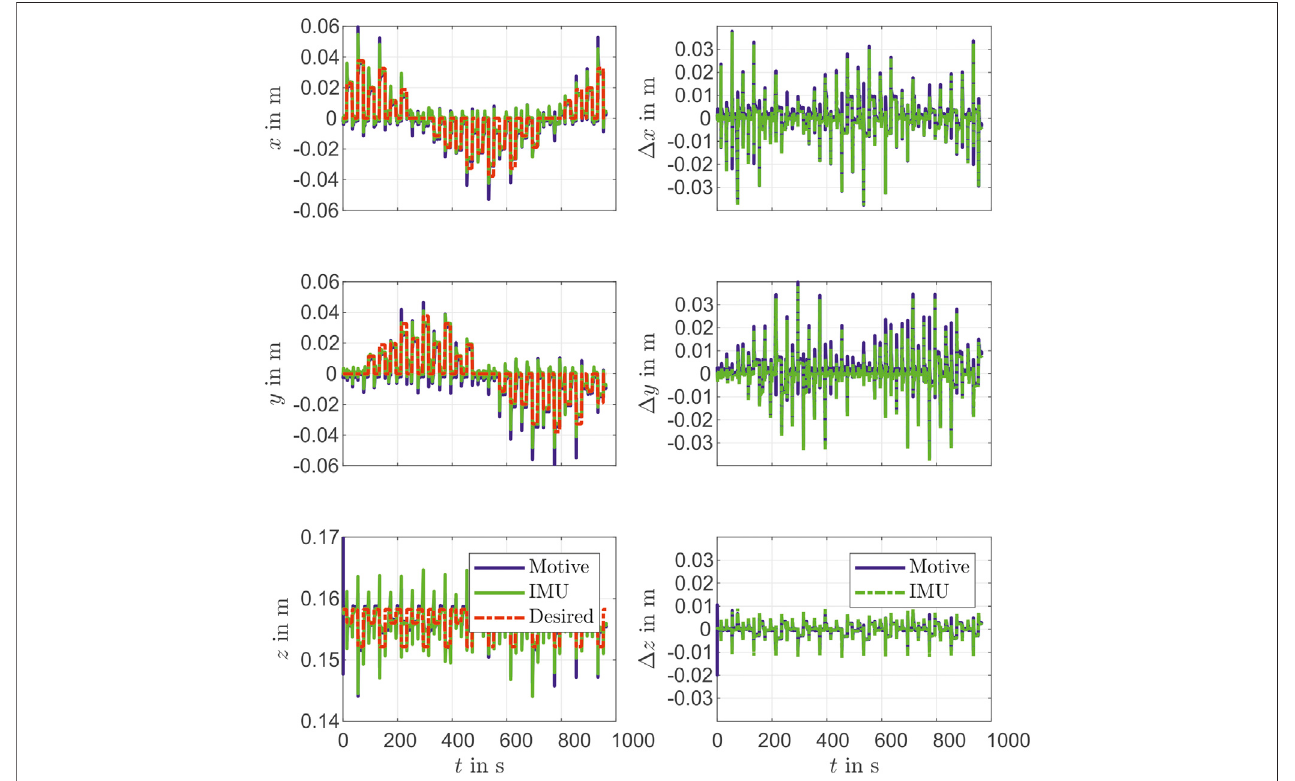
FIGURE 9 | Desired and measured Cartesian parameters during validation of PID Controller.